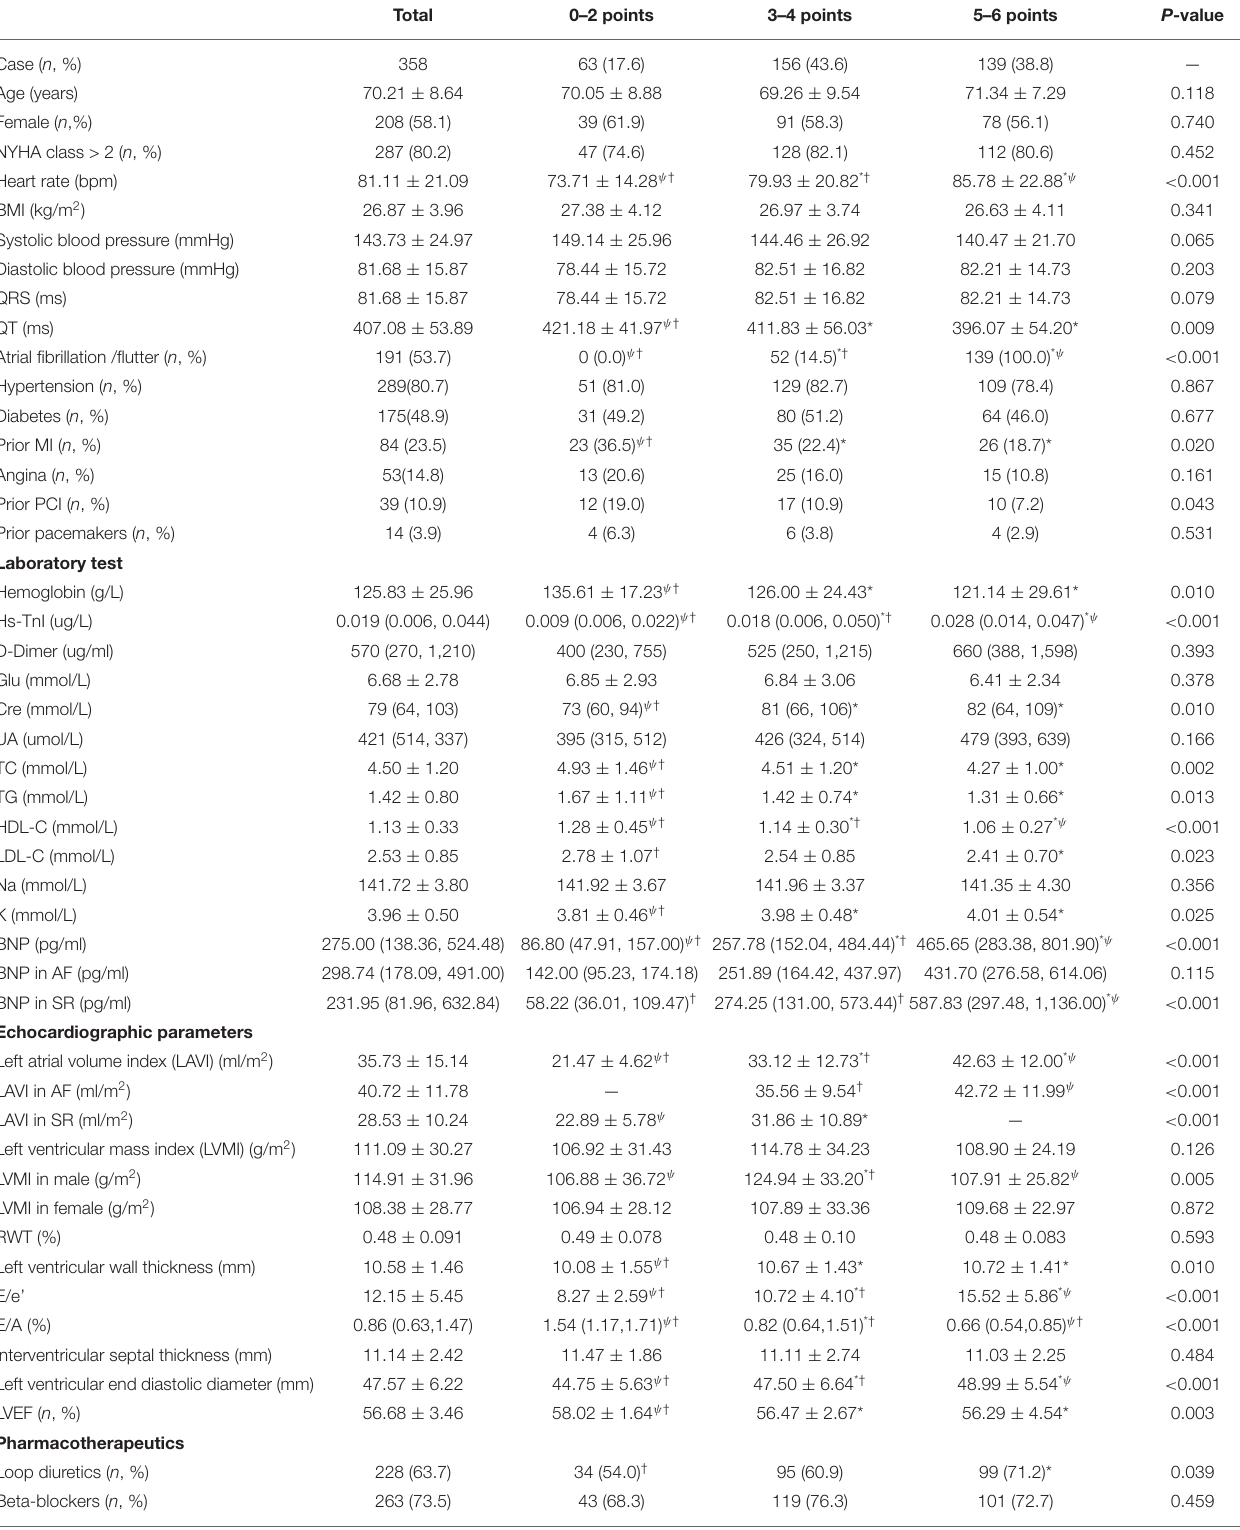
TABLE 2 | The baseline